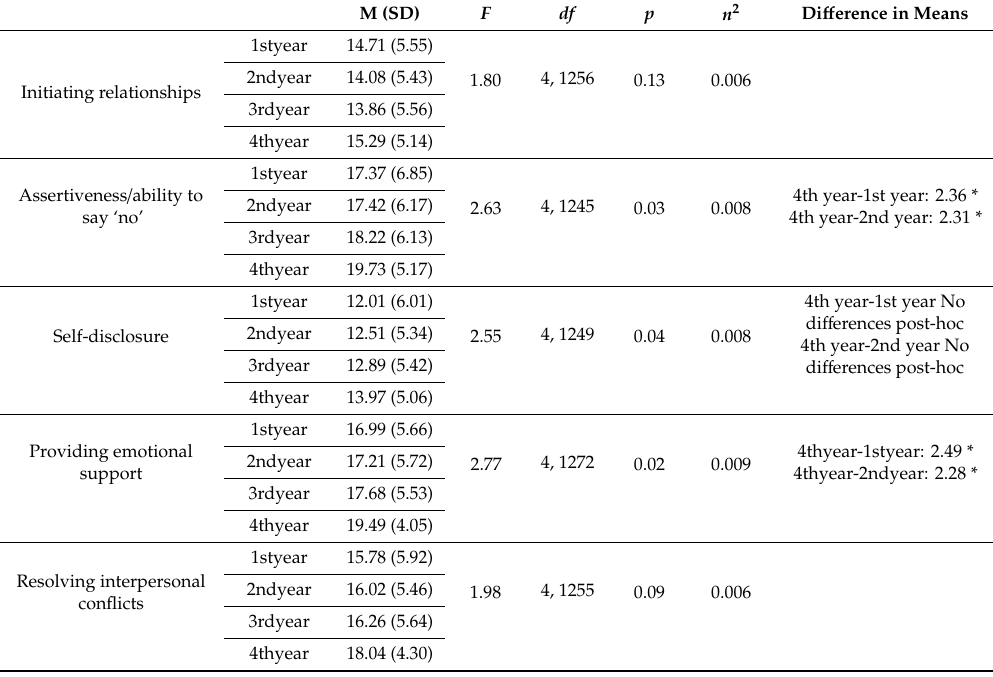
Table 2. Significant di ff erences by school year in the competency domains.